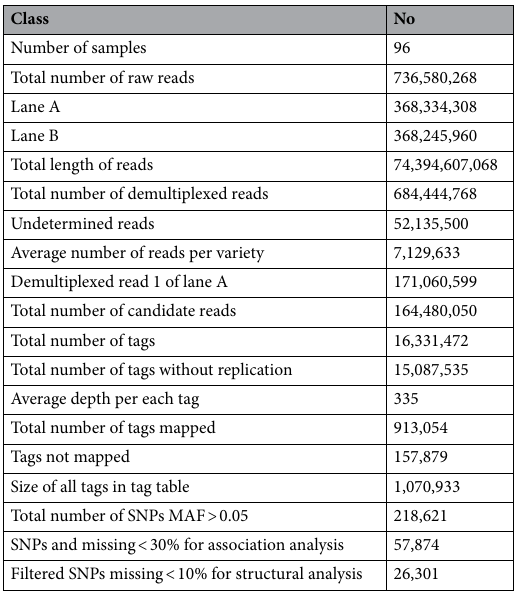
Table 1. Summary of genotype-by-sequencing (GBS) in cabbage varieties. SNP, single nucleotide polymorphism; MAF, minor allele